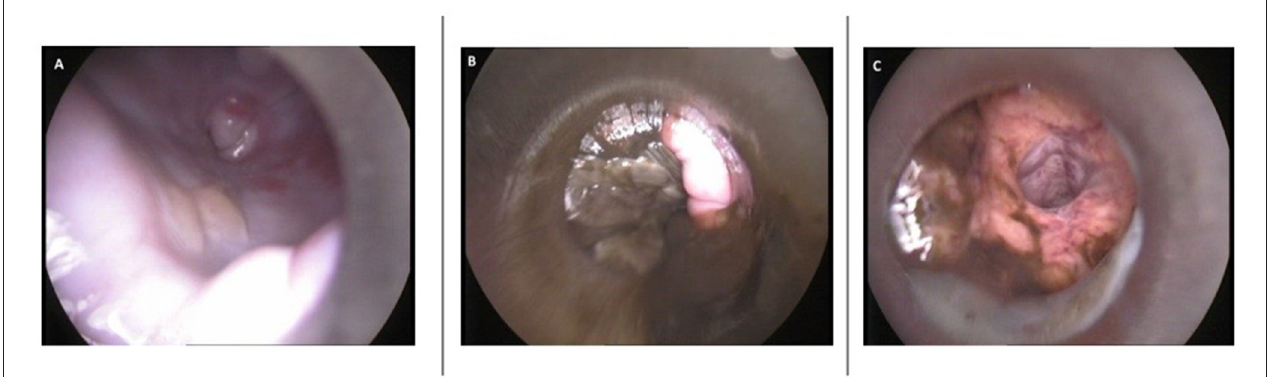
FIGURE 1 | Images of vaginoscopy. (A) Aspect of cranial vaginal mucosa showing red and pale colored patchwork. A small amount of clear yellow mucus can be seen ventrally (D69). (B) Fetal membranes and dark green mucous discharge in vagina (D71). (C) A wide uterine lumen with green mucous discharge confirming open cervix